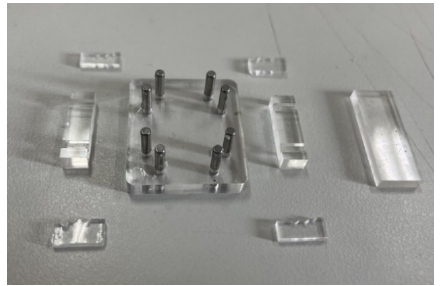
Figure 19. FBG sliding tactile sensor mold.